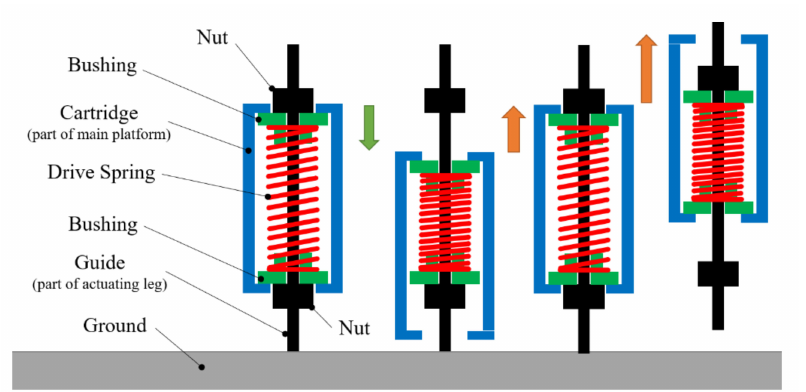
Figure 4. Principle of compression of the drive springs suspension in BB-0B (floating spring).